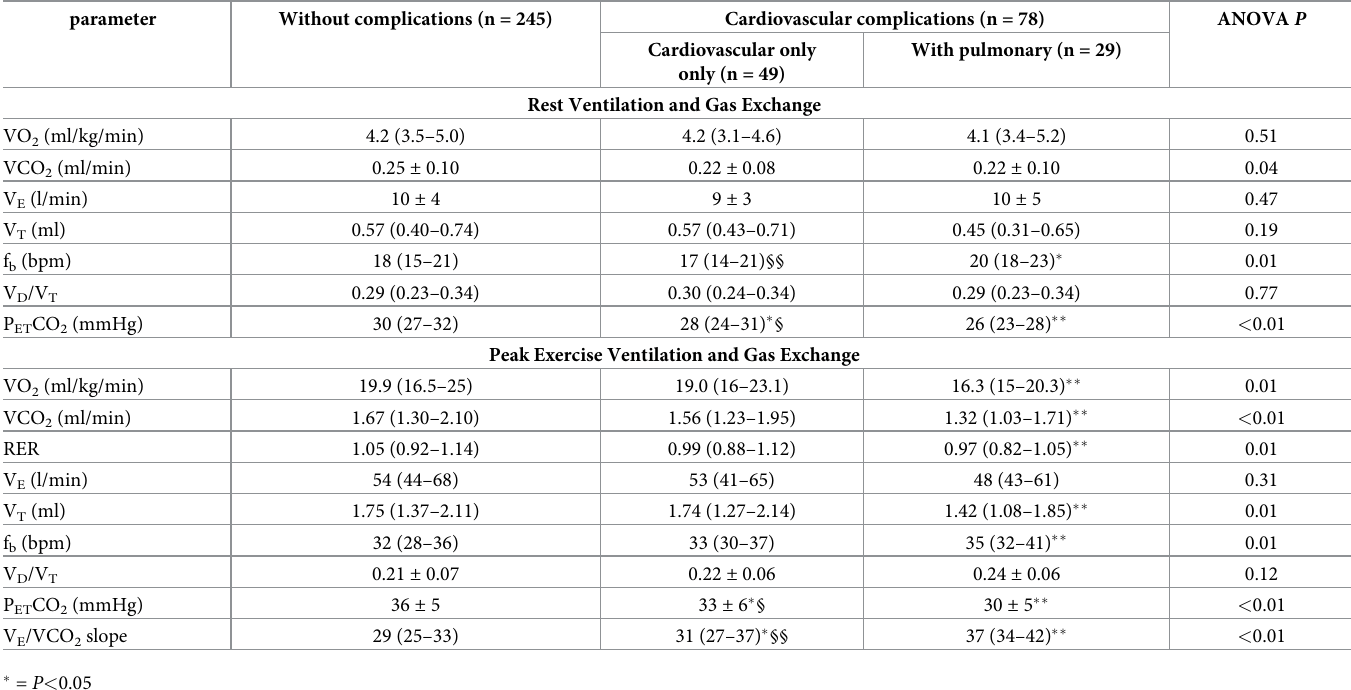
Table 4. Cardiopulmonary exercise testing comparison.